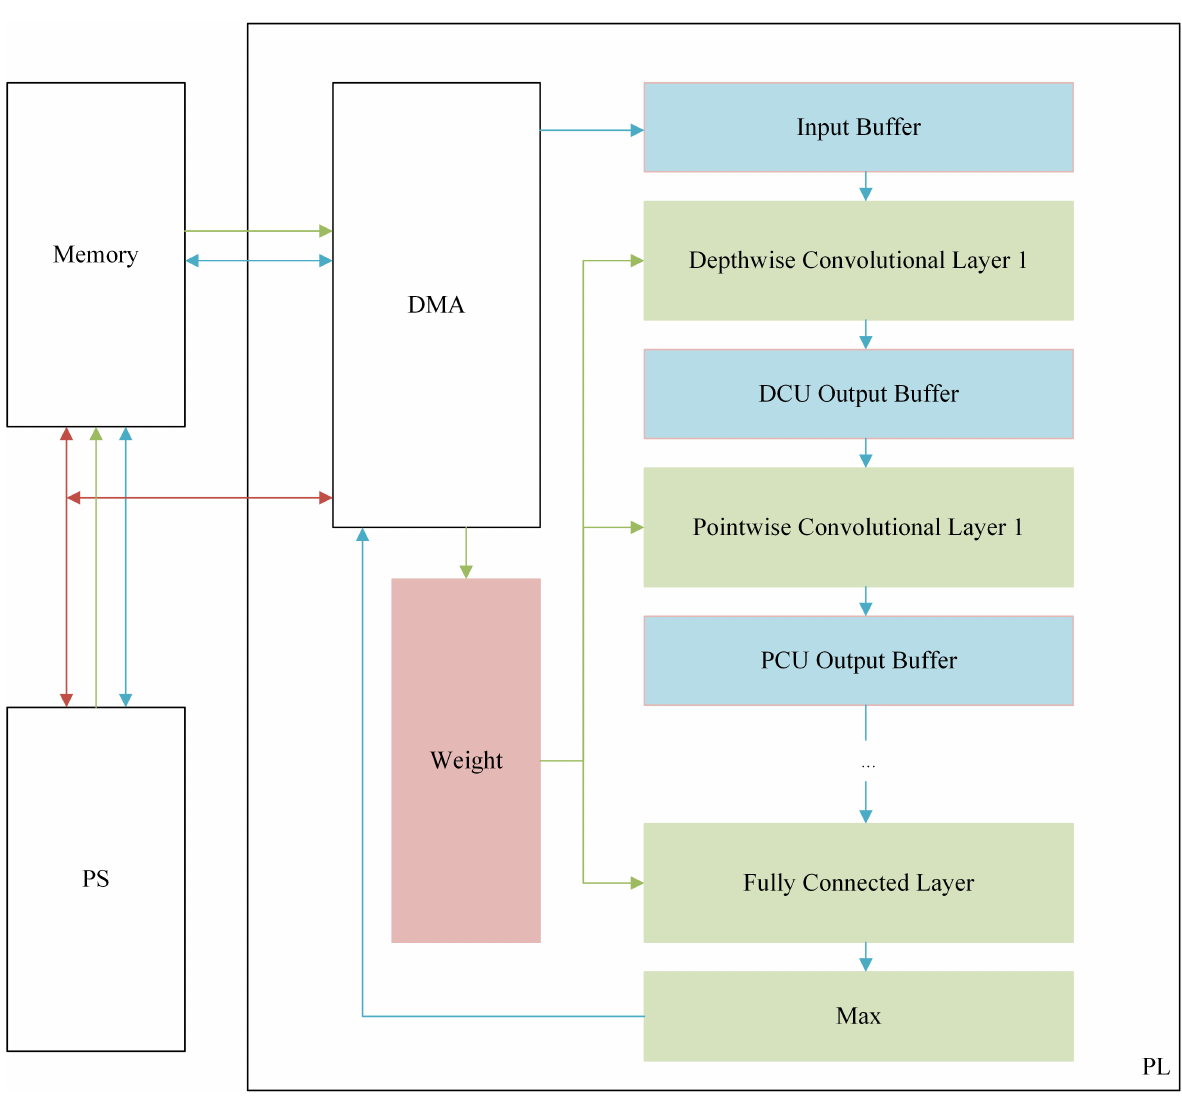
Figure 4. An overview of the FPGA implementation architecture of OI-DSCNN. The red line is the control path. The green line is the weight path. The blue line is the data